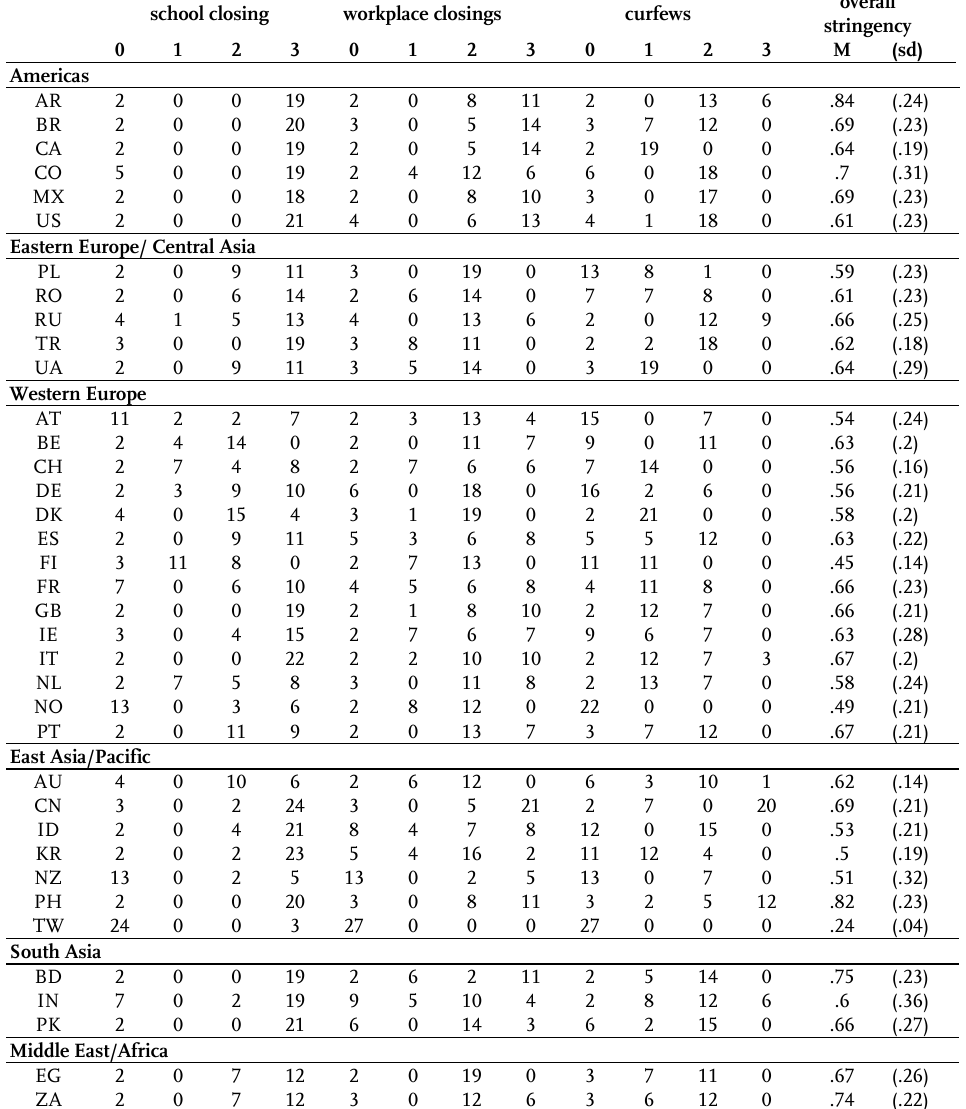
Table 2 : Overview on national-level lockdown intensity (# of weeks/mean